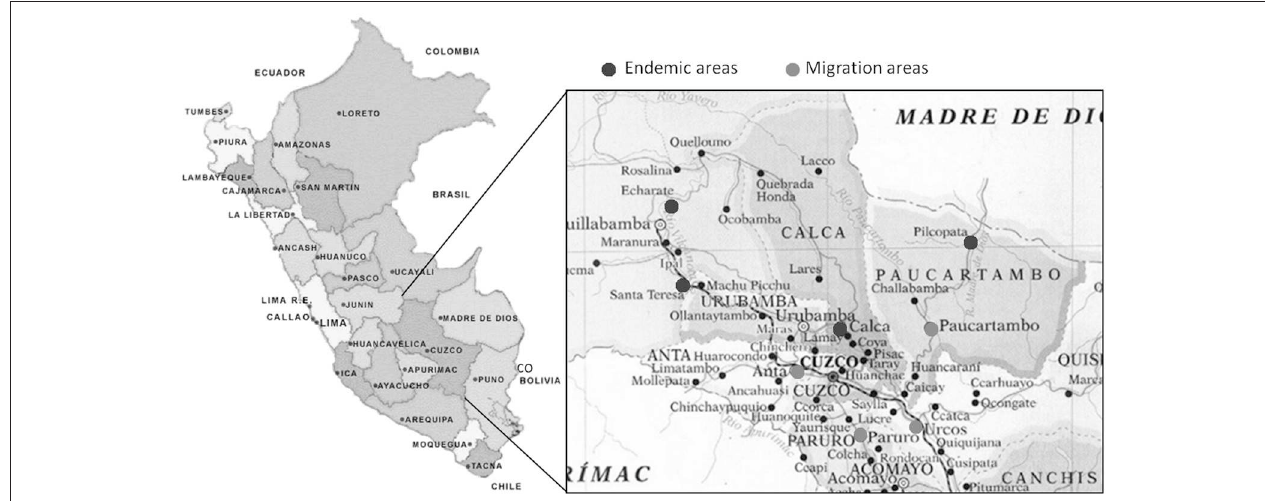
FIGURE 1 | Endemic areas of American Tegumentary Leishmaniasis in Peru. Map showing the areas de migration from the highlands of Cusco to the endemic areas of American Tegumentary Leishmaniasis